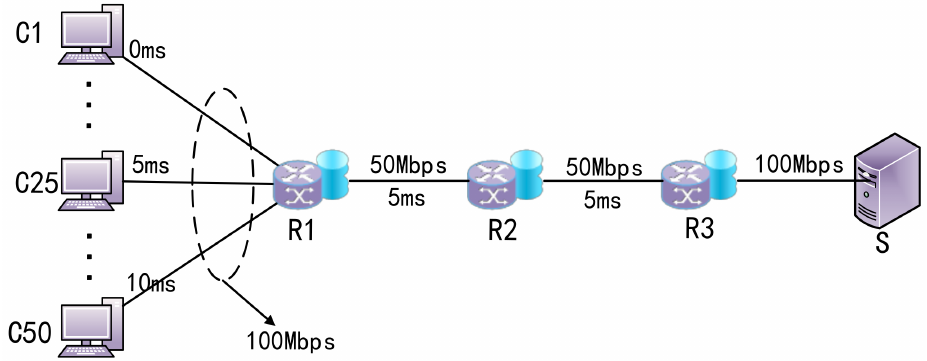
Figure 6. Simulation topology.